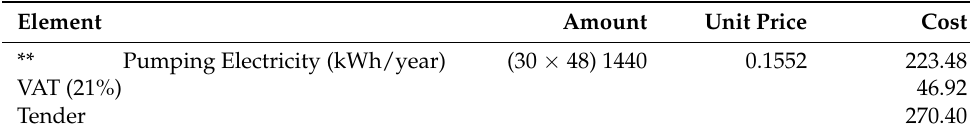
Table 6. Operational costs from ST